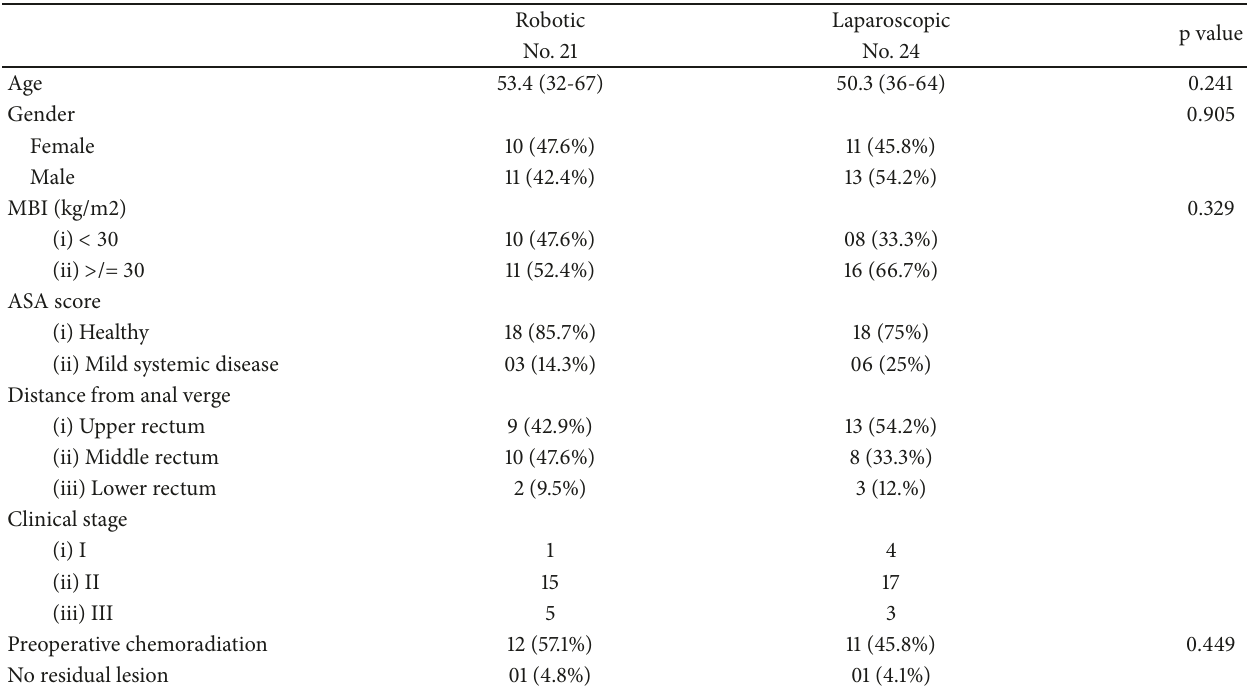
Figure 3: Patient enrollment. Table 1: Patients demographic data and